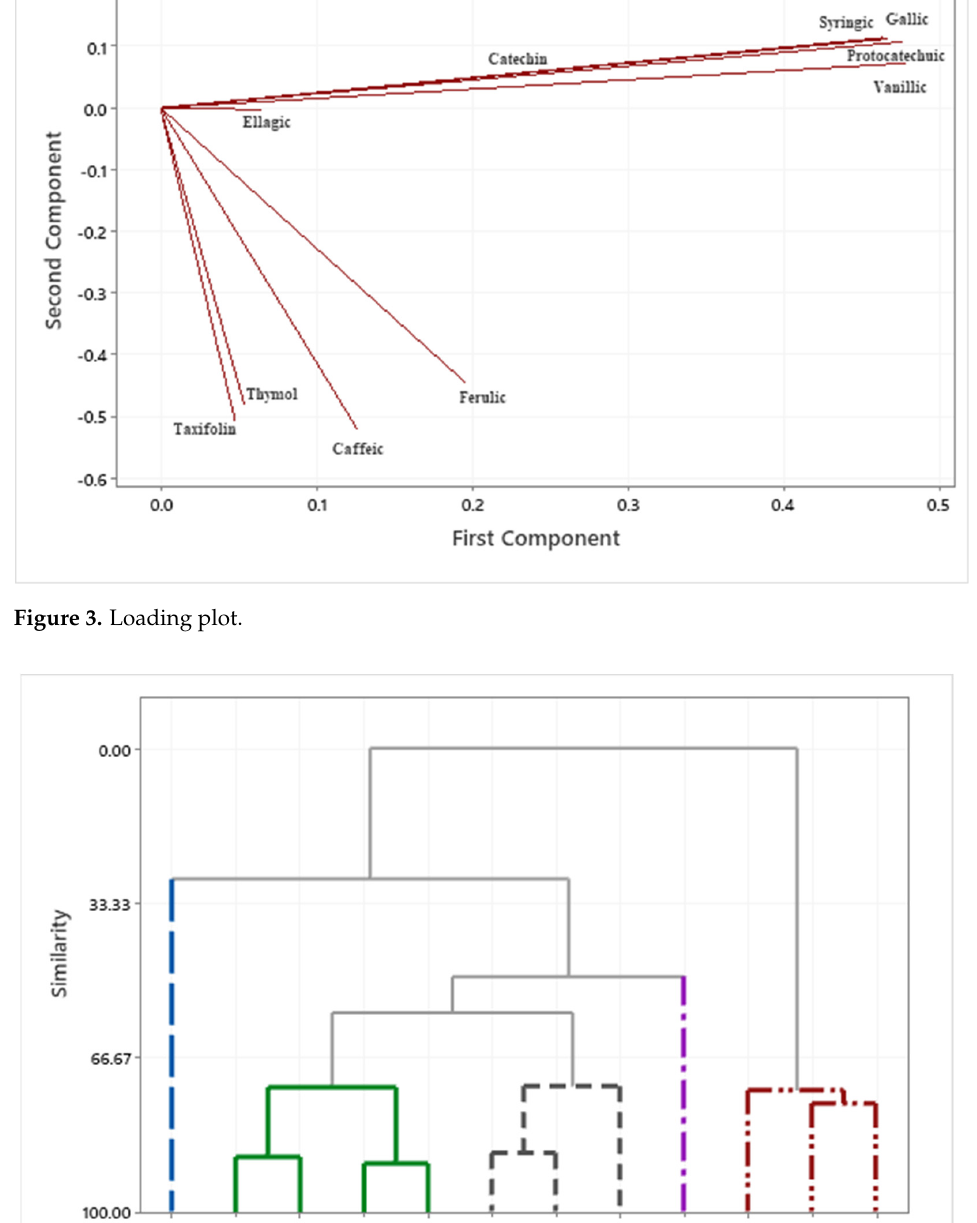
Figure 4. Cluster analyses of the pecan shell extracts. Table 7. Pearson correlation coefficient for individual phenolic compounds and DPPH, ABTS and FRAP activity of the pecan nut shell extracts.